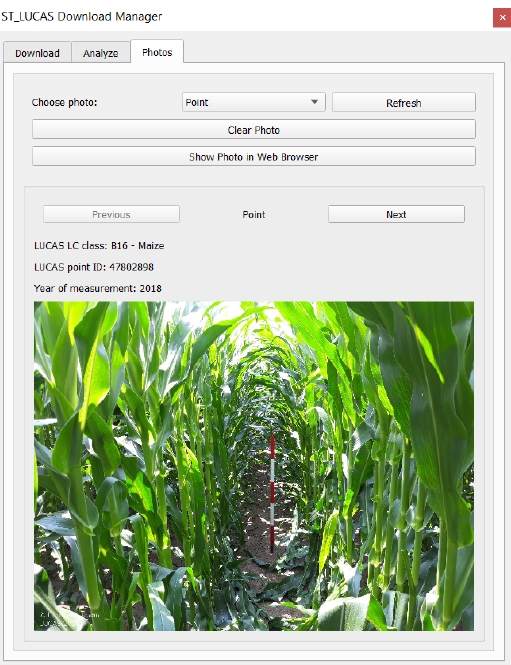
Figure 8. Showing LUCAS photos from the GISCO service by the ST_LUCAS QGIS